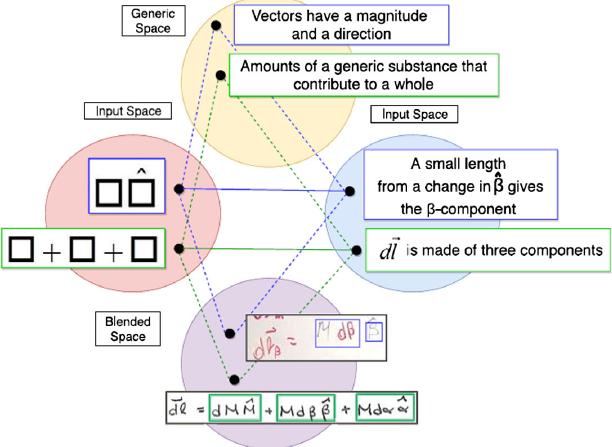
FIG. 4. Blending diagram from Schermerhorn and Thompson [20]. In this example, students ’ construction of a differential length vector comes from attending to the magnitude and direction of each component and to the sum of components from three different directions. Combining their content knowl- edge with the mathematical templates, the students write the final expression. The determination of the terms in each magnitude (not shown here) is also the result of blending different symbolic forms with content knowledge.